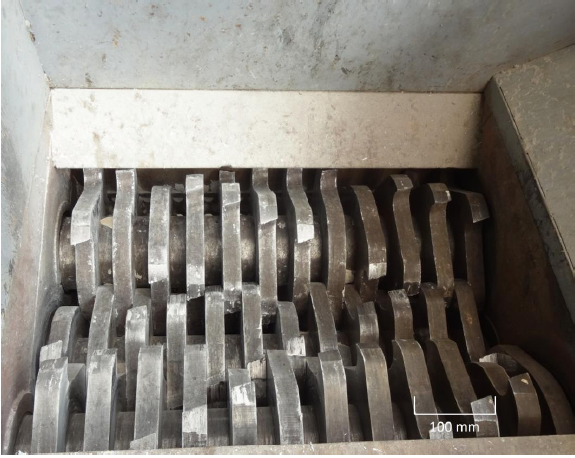
Figure 2. Inside view of the shredder DECOVAL 3K7/30.